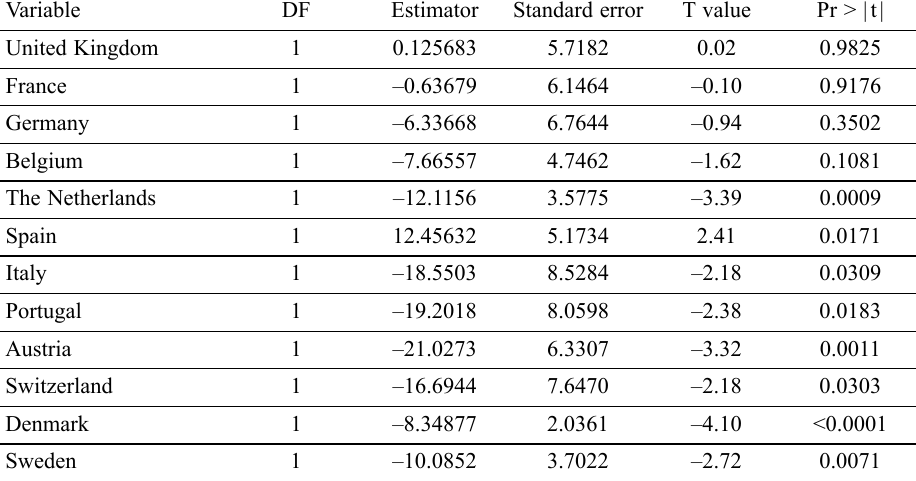
Table 4. Parameter estimates, value as dependent